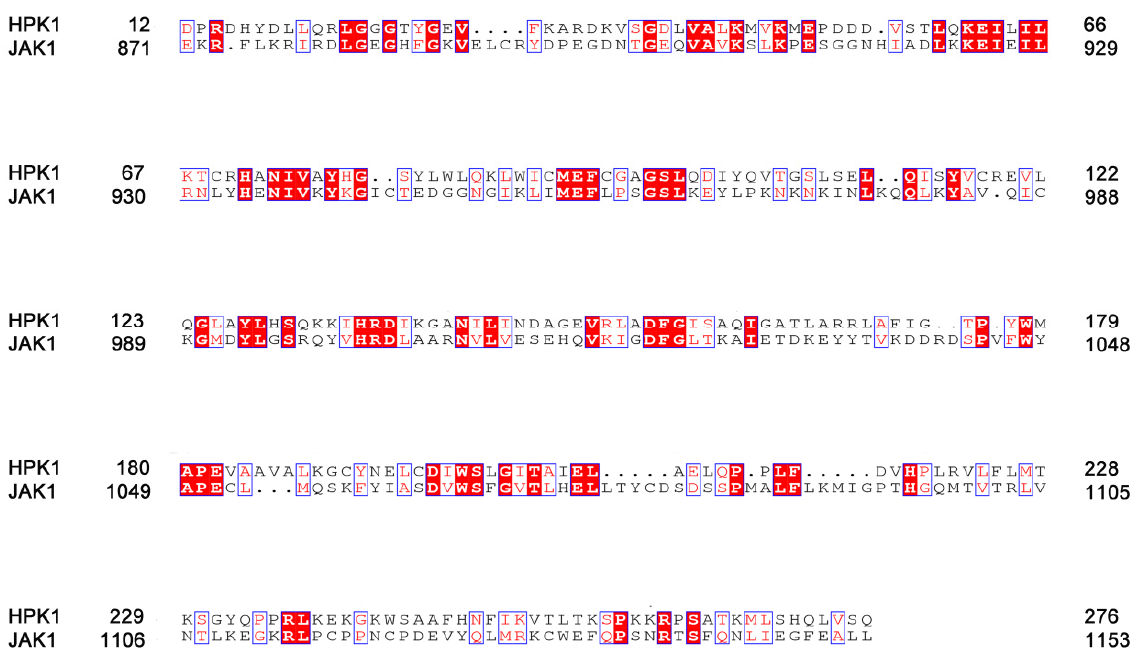
Figure 2. Sequence alignment of HPK1 and JAK1. The white characters with red background indicated that the amino acid sequences are completely identical, and the red characters with white background indicated that the amino acids are different but similar in properties.